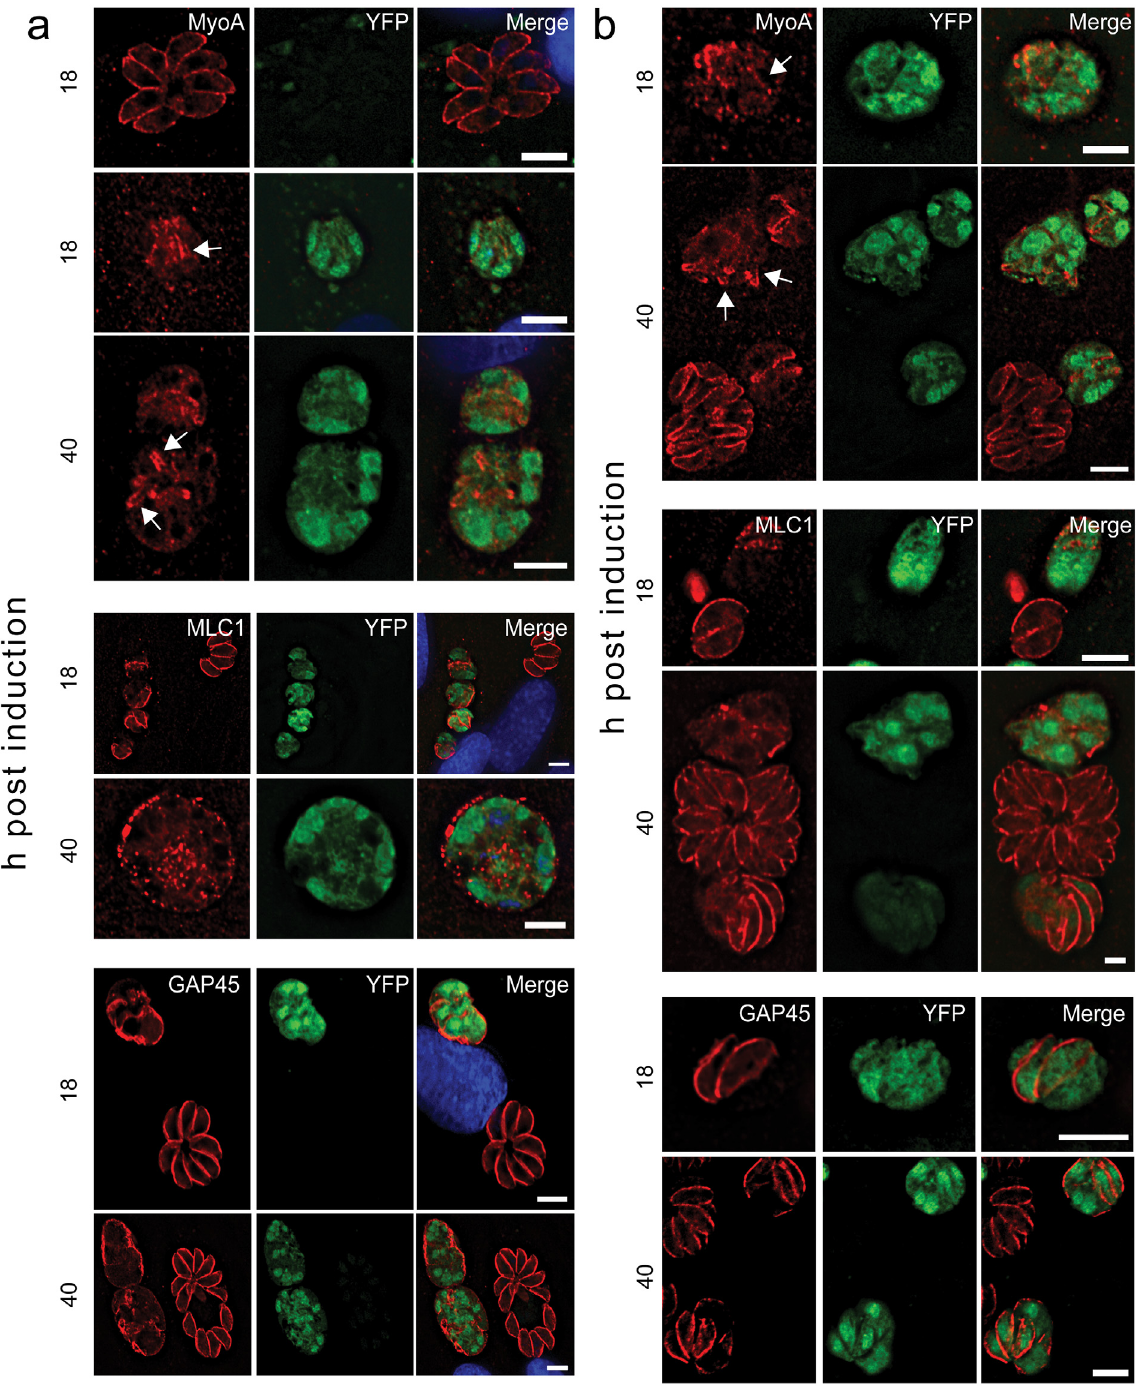
Fig 4. Conditional deletion of gap40 or gap50 results in altered localisation of components of the glideosome. ( a ) Deletion of gap40 leads to loss of MyoA staining from the periphery of the vacuole at 18 and 40 h post induction although some MyoA-positive structures were visible within the vacuole (arrows). Using a specific antibody, MLC1 localisation was also significantly affected at both time points tested. GAP45 was still seen at the periphery of vacuoles however abnormal structures were visible and there was no delineation between parasites in the same vacuole. ( b ) Similar results were observed upon deletion of gap50 , with a loss of peripheral MyoA staining and abnormal morphology using MLC1 and GAP45 antibodies. Scale bar 10 μ m.